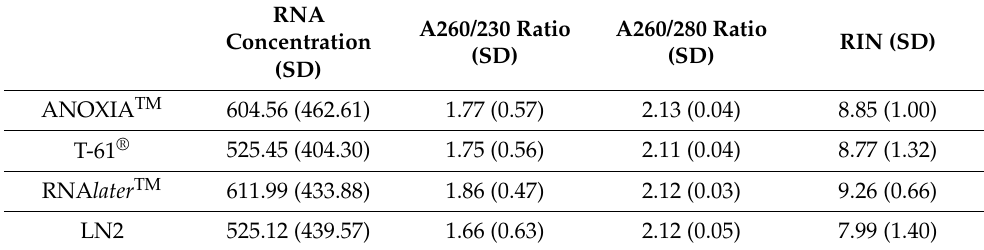
Table 1. Mean and standard deviations of RNA quality parameters for the experimental samples classified based on euthanasia method and storage